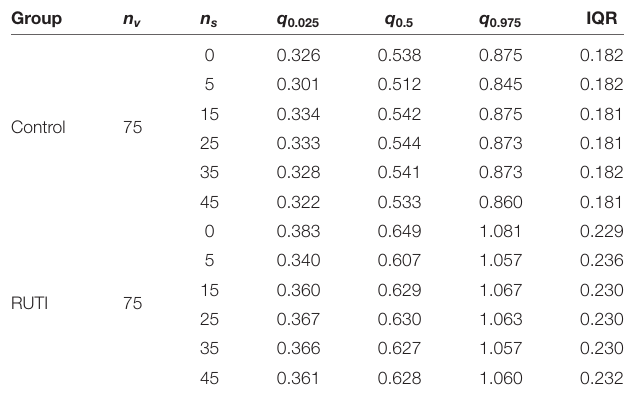
TABLE 2 | Summary statistics (2.5, 50, and 97.5% quantiles) and interquartile range (IQR) of posterior distributions of the odds from each group after